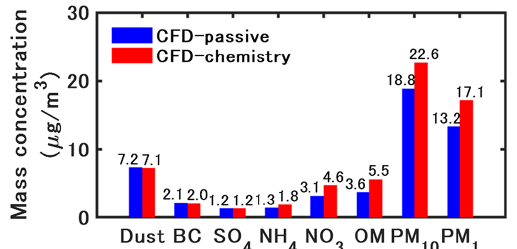
Figure 16. Time-averaged concentration of PM 10 , PM 1 and the chemical compounds of PM 10 from 05:00 to